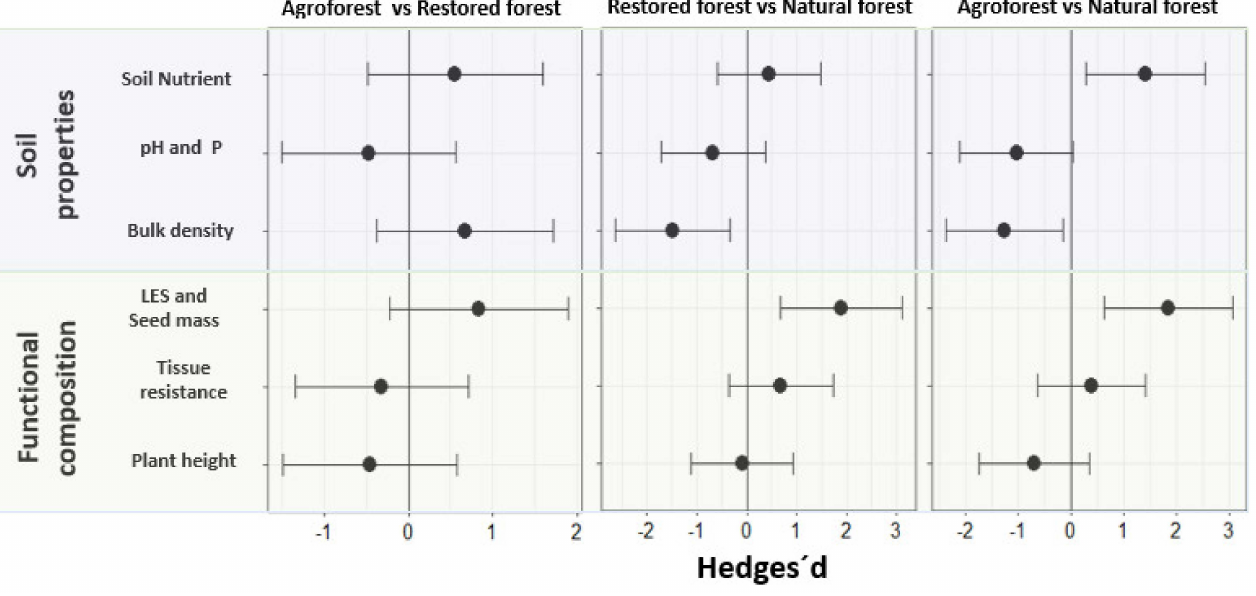
Figure 2. Mean effect size (Hedges’d) and bias-corrected 95% bootstrap confidence intervals for differences between the ecosystem types for each PC dimension of the functional composition and soil parameters (see Table 2).